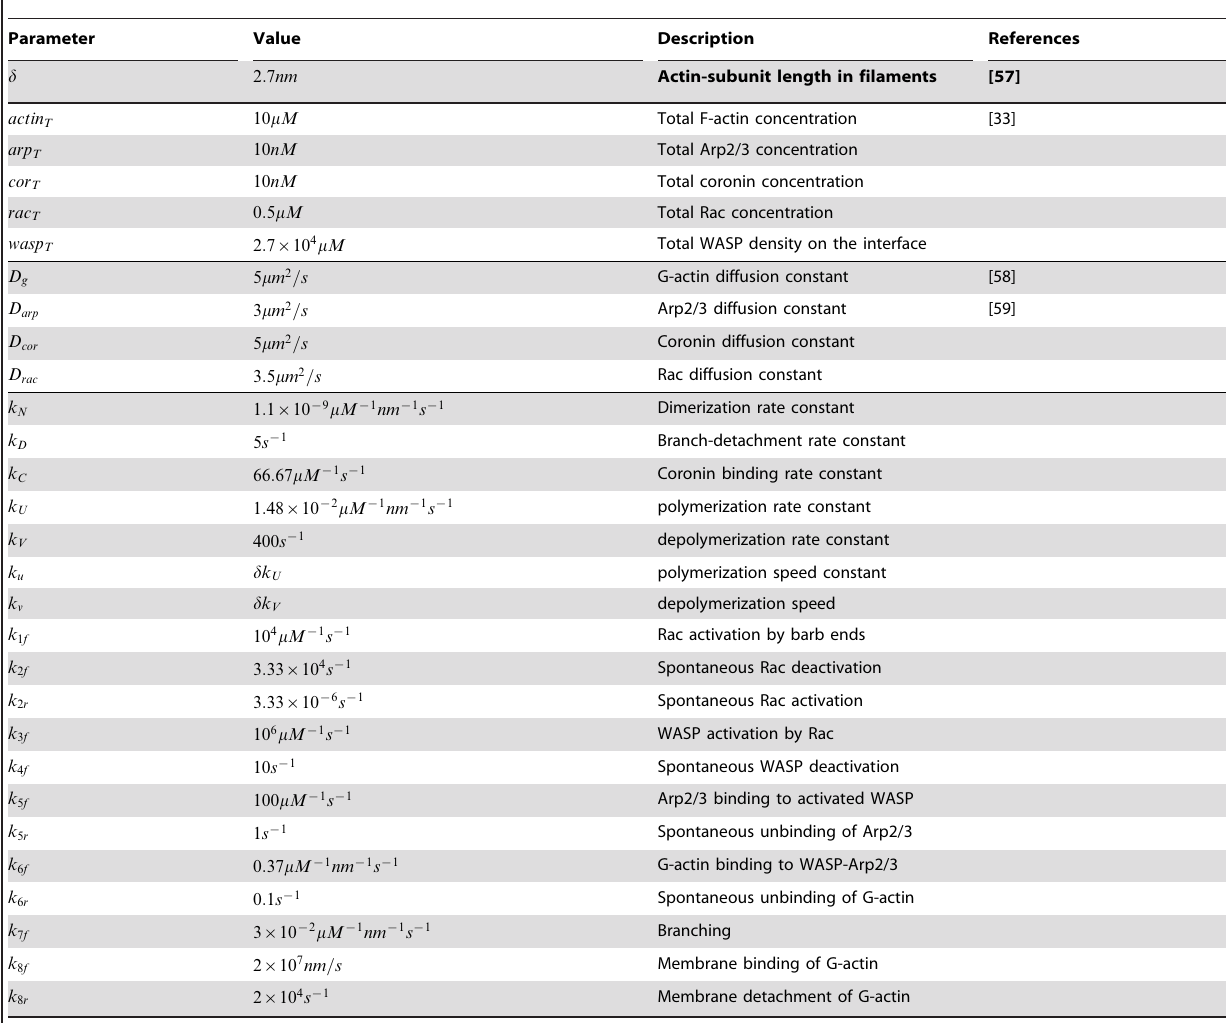
Table 2. Parameter values used in the actin-wave